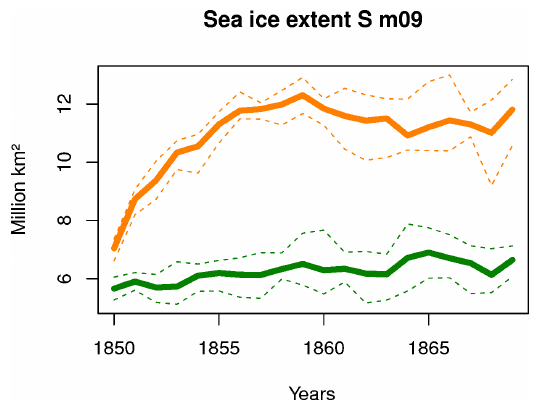
Figure 6. Time series of ensemble mean Antarctic September sea ice extent in the two experiments e011 (orange) and m06e (green). The dashed lines indicate the ensemble minimum and maximum (i.e., the range). Sea ice extent is calculated as the sum of areas of ocean pixels containing more than 15% sea